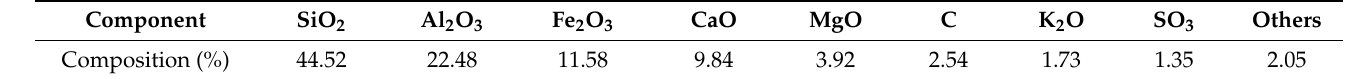
Table 1. Chemical composition of raw coal power plant